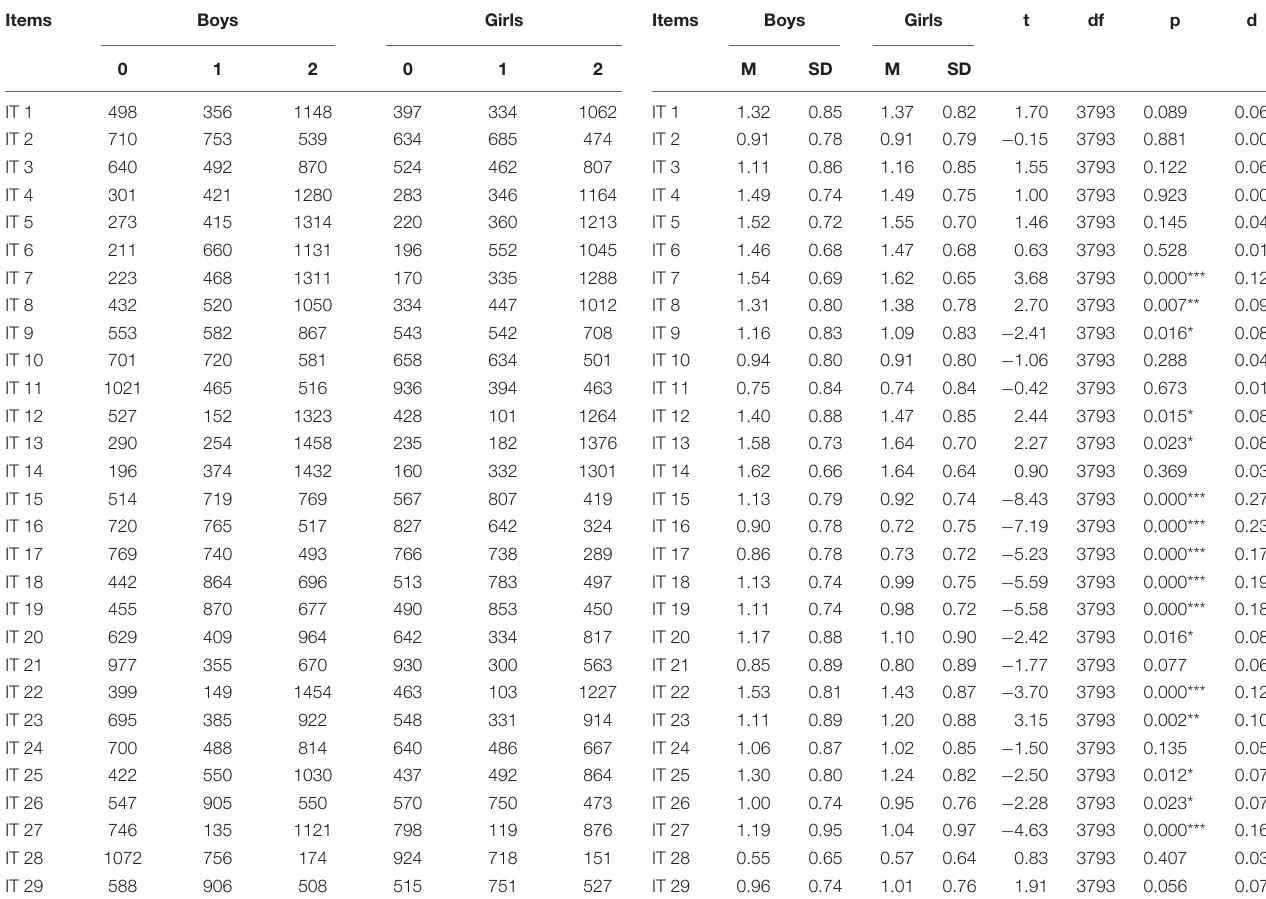
TABLE 2 | Frequencies for each item response by sex. TABLE 3 | t test for independent samples by